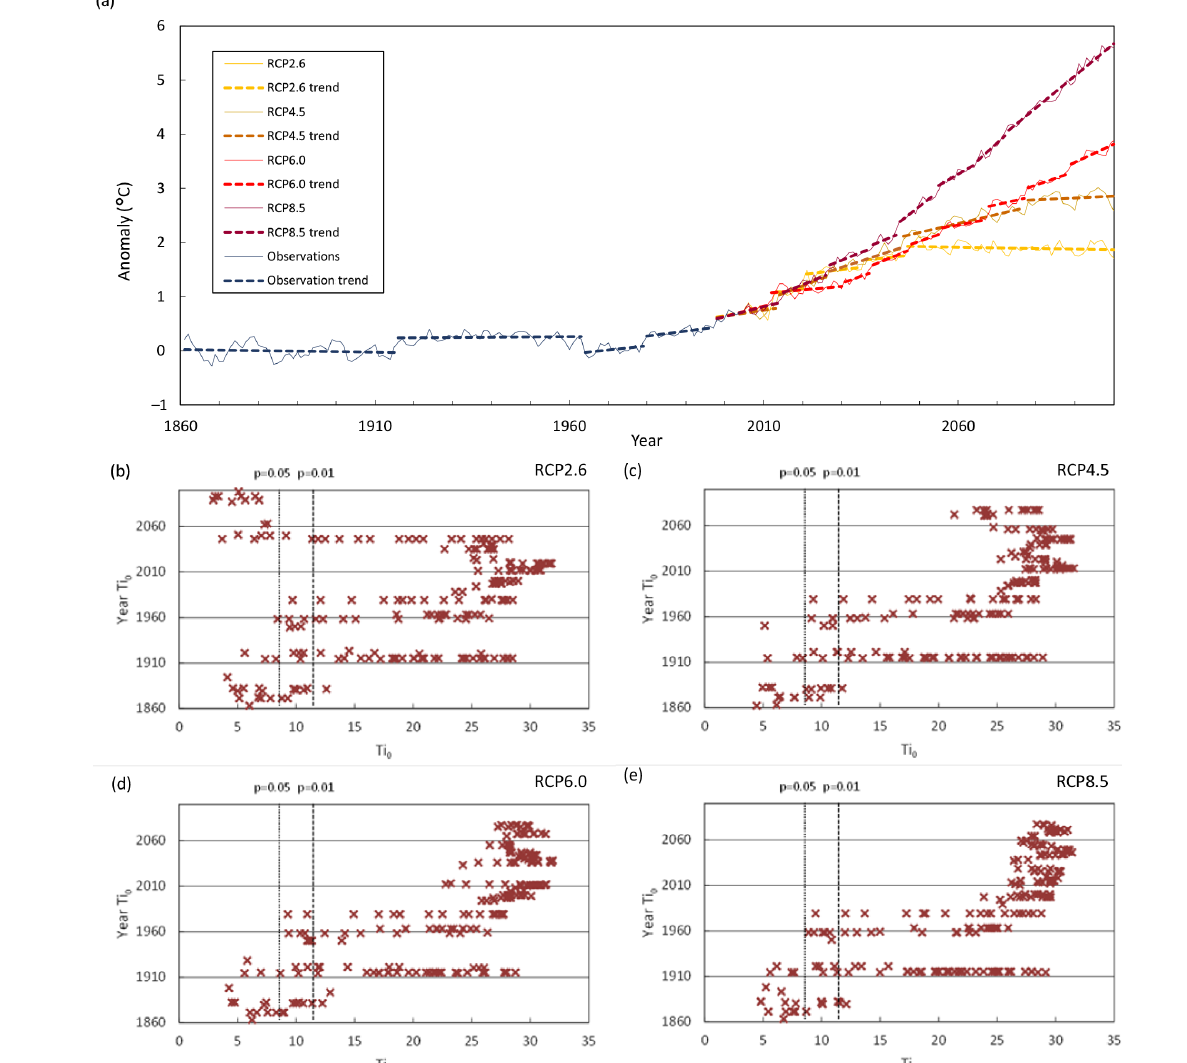
Figure 10. Global mean surface temperature as analysed by the multistep bivariate test. (a) Step and trend breakdown of global mean surface temperature in the RCP2.6, 4.5, 6.5 and 8.0 simulations from the HadGEM-ES model, run 3; (b–e) T i 0 results from a 40-year moving window for the RCP2.6, 4.5, 6.5 and 8.0 simulations